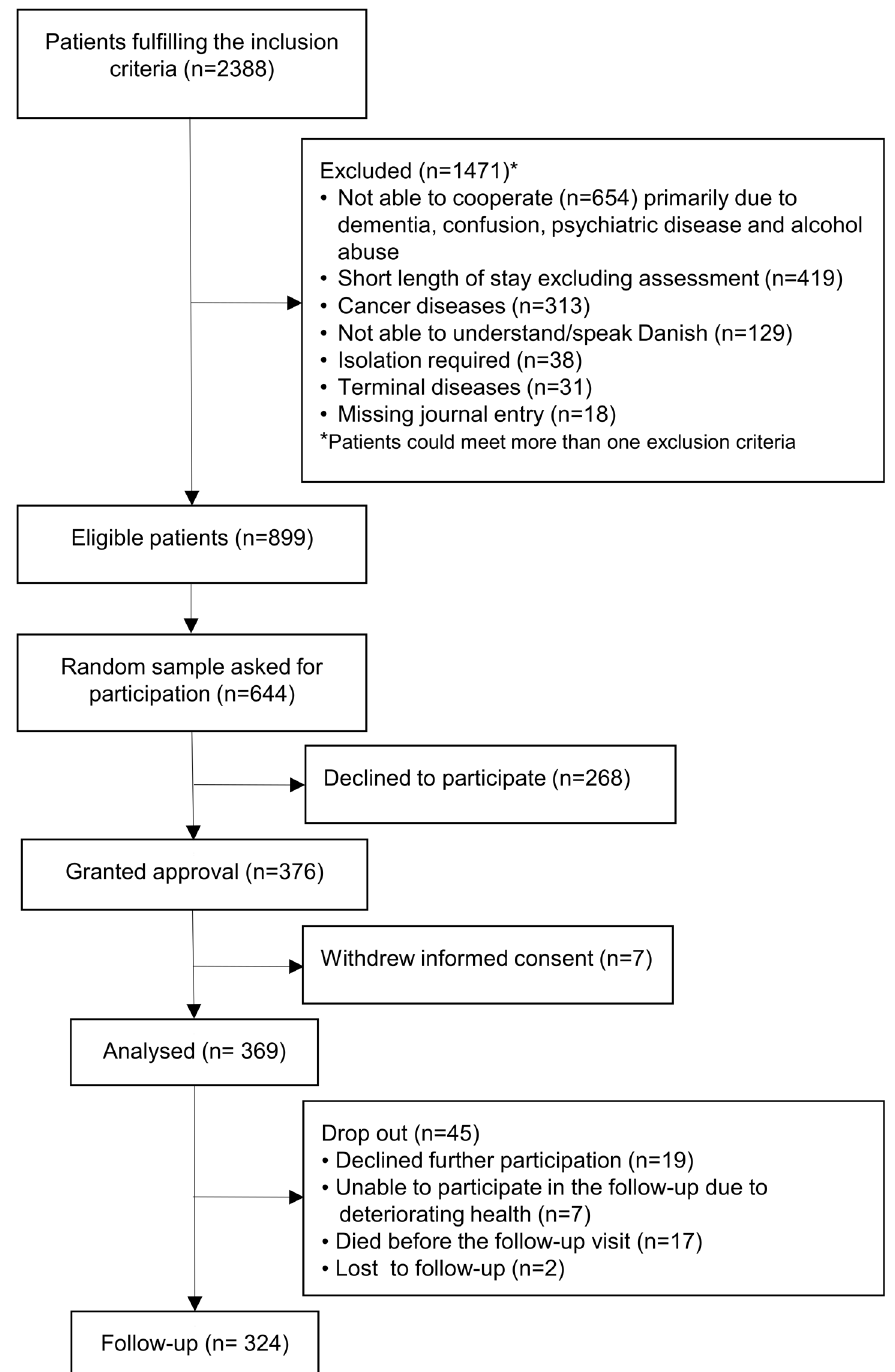
Fig 1. Inclusion of patients in the study (N = 369).